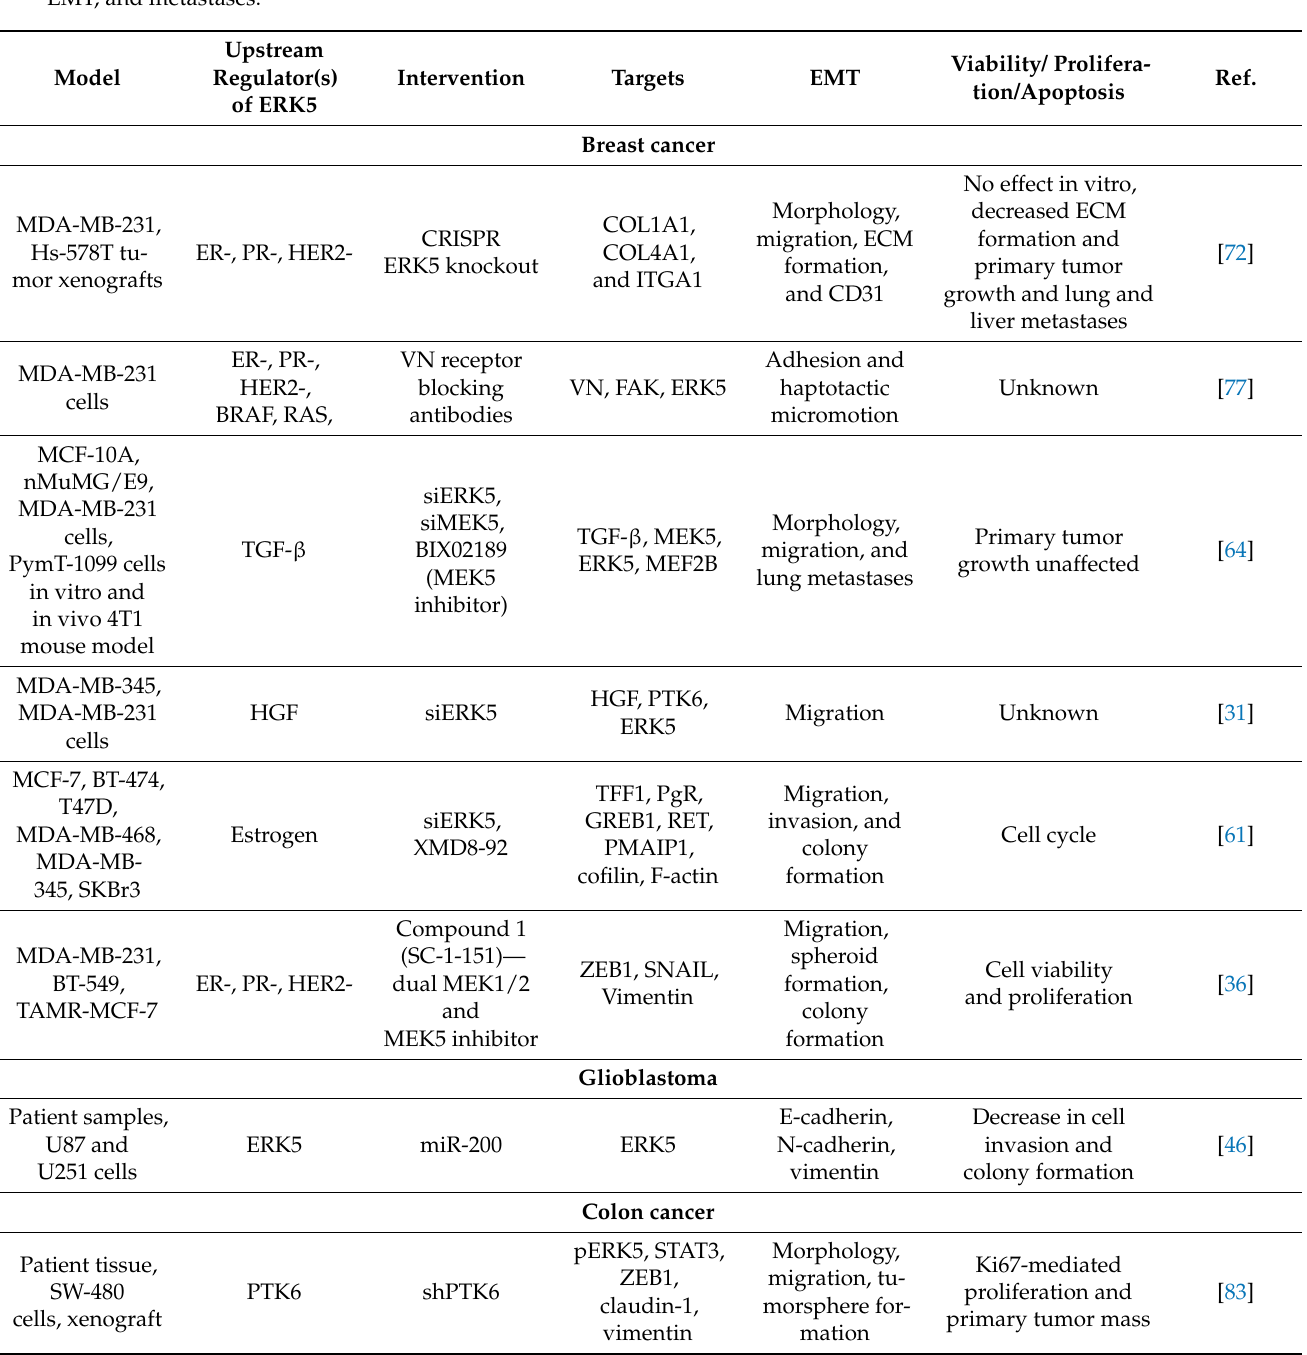
Table 1. Mechanisms modulating the extracellular signal-regulated kinase (ERK5) pathway and effect of targeting ERK5 on EMT, and